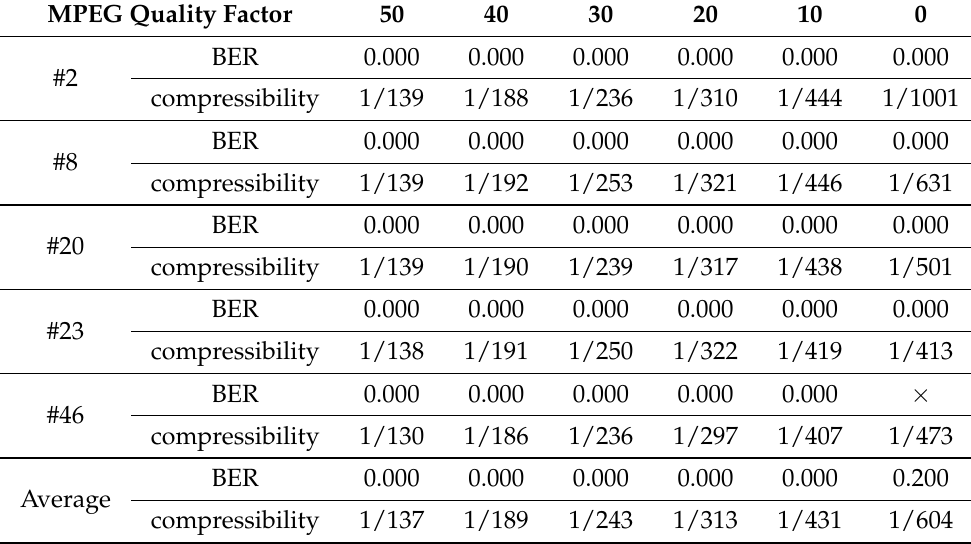
Table 5. Robustness results for the benchmark Set-5 with the watermark strength α = 0.9 (PSNR